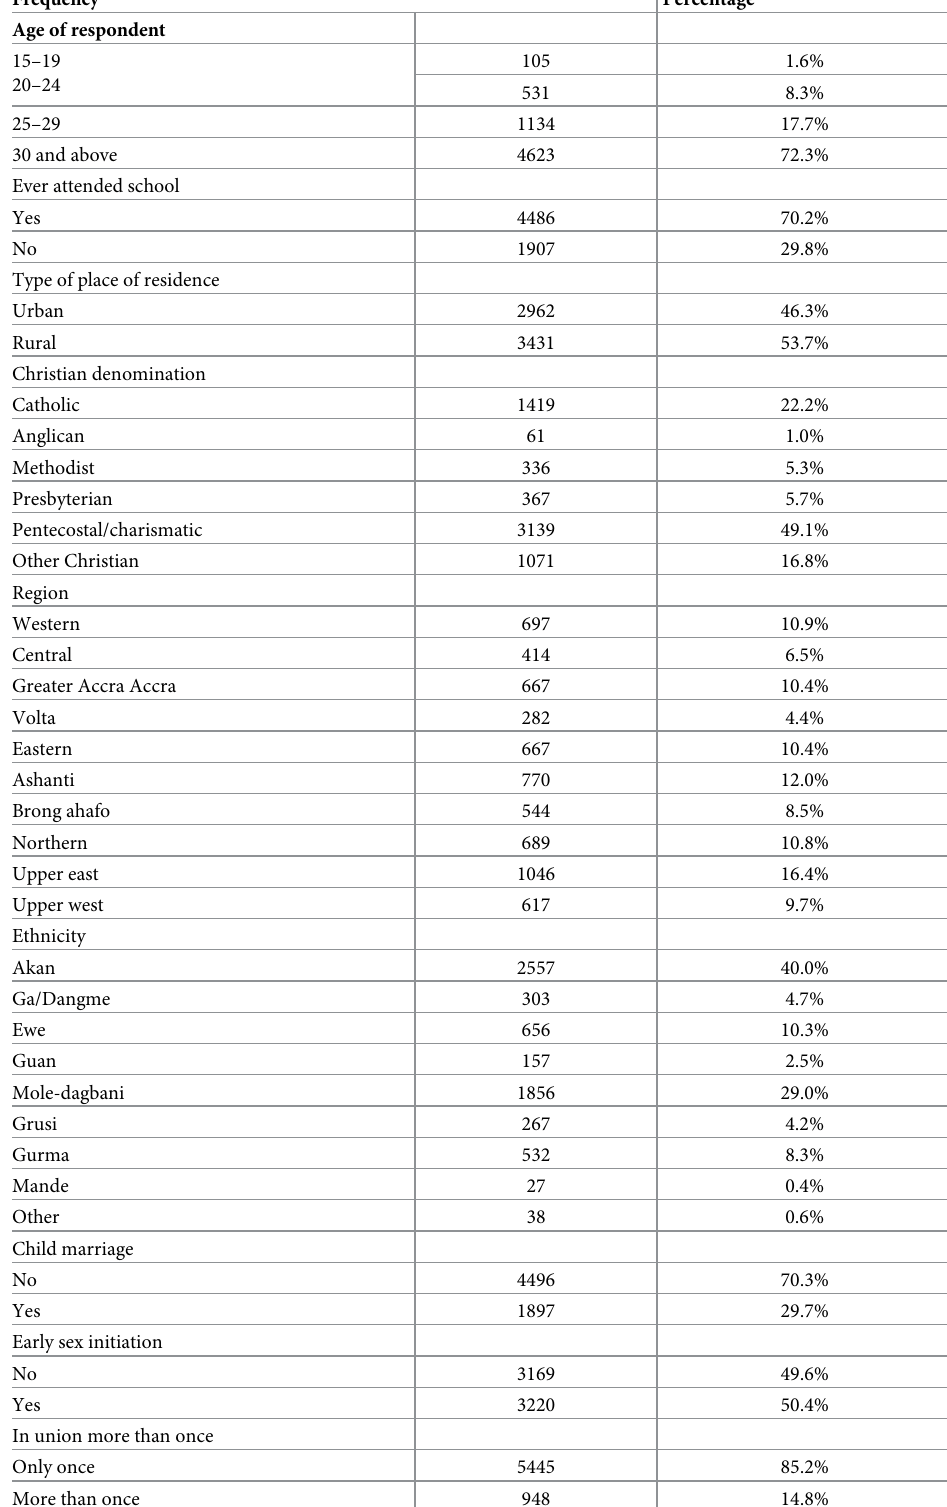
Table 1. Demographic characteristics of study